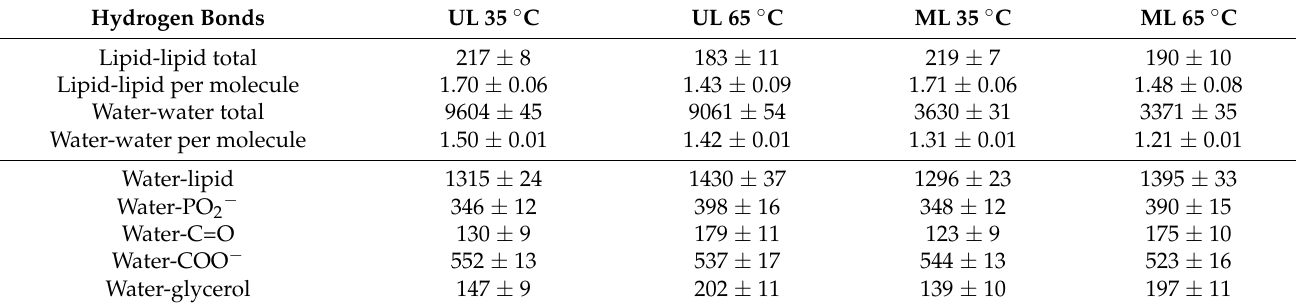
Table 3. Average number of hydrogen bonds formed between specific groups or molecules.